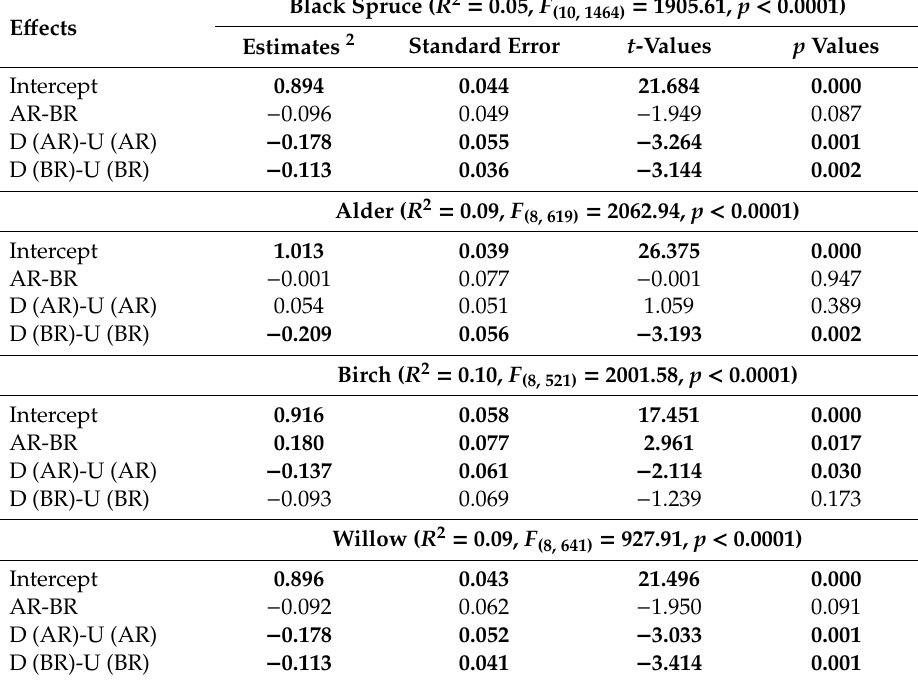
Table 2. Generalized linear mixed e ff ect model results for annual radial growth with the year as a random factor and time of road construction (After road—AR and Before road—BR) and the interaction of time of road construction and side of the road as fixed factors (Upstream—U and Downstream—D) showing the e ff ects on annual tree ring growth 1 of black spruce in the bog, and alder, birch and willow in the fen before (BR) and after road (AR) construction, Carmon Creek, Peace River, Alberta, Canada. E ff